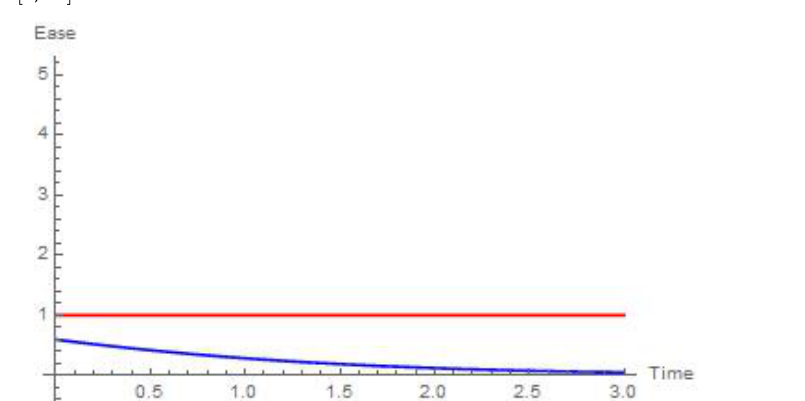
Figure 5. Optimal Weibull (red) and Chen (blue) controllers when δ 1 = 1 = δ 2 and λ 1 = 1 = λ 2 for ( t , x ) ∈ [ 0,1 ] × [ 0,10 ] .